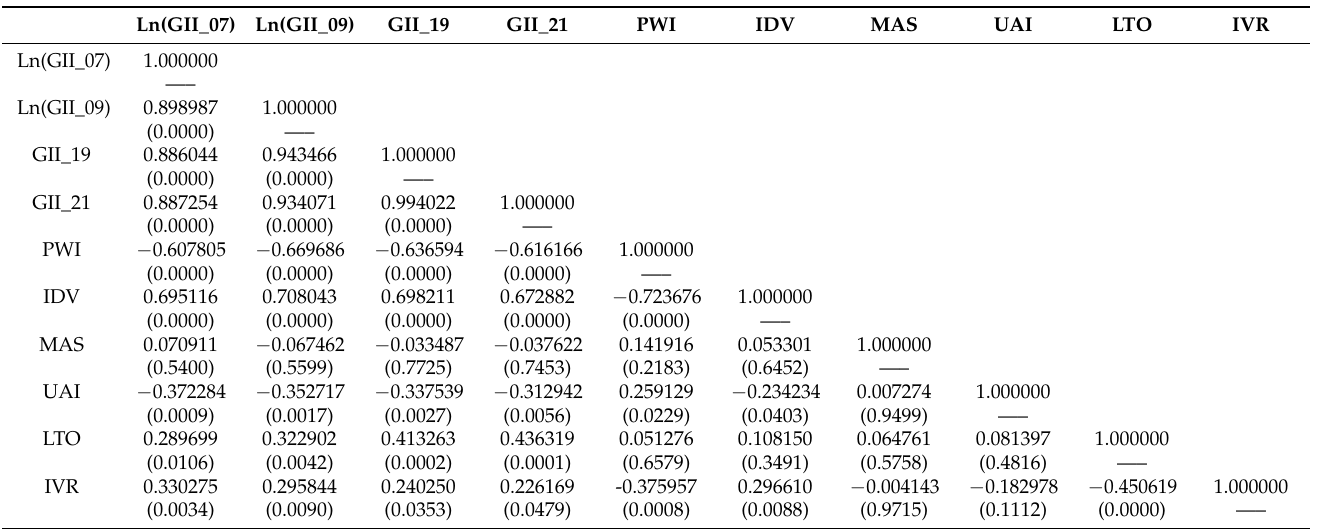
Table 4. Pearson’s correlation